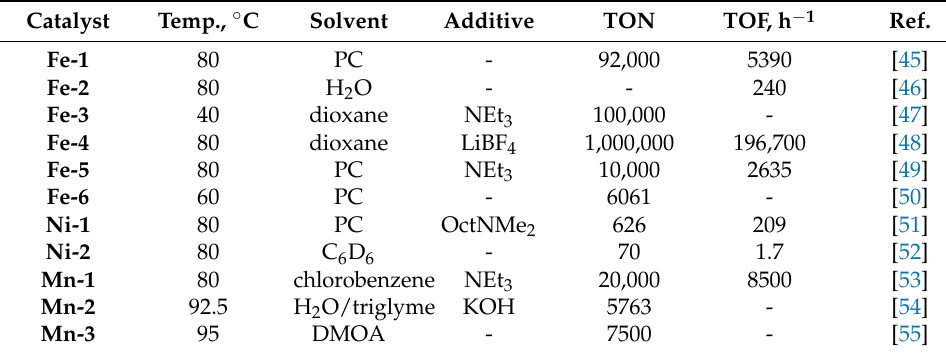
Figure 7. Non-precious metal catalysts for FADH. Table 2. Selected non-precious metal catalysts for FADH.